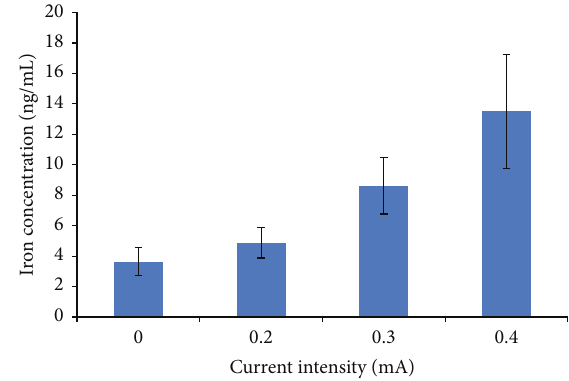
Figure 2: Iron concentrations of collected liquid following one-time RI with different current